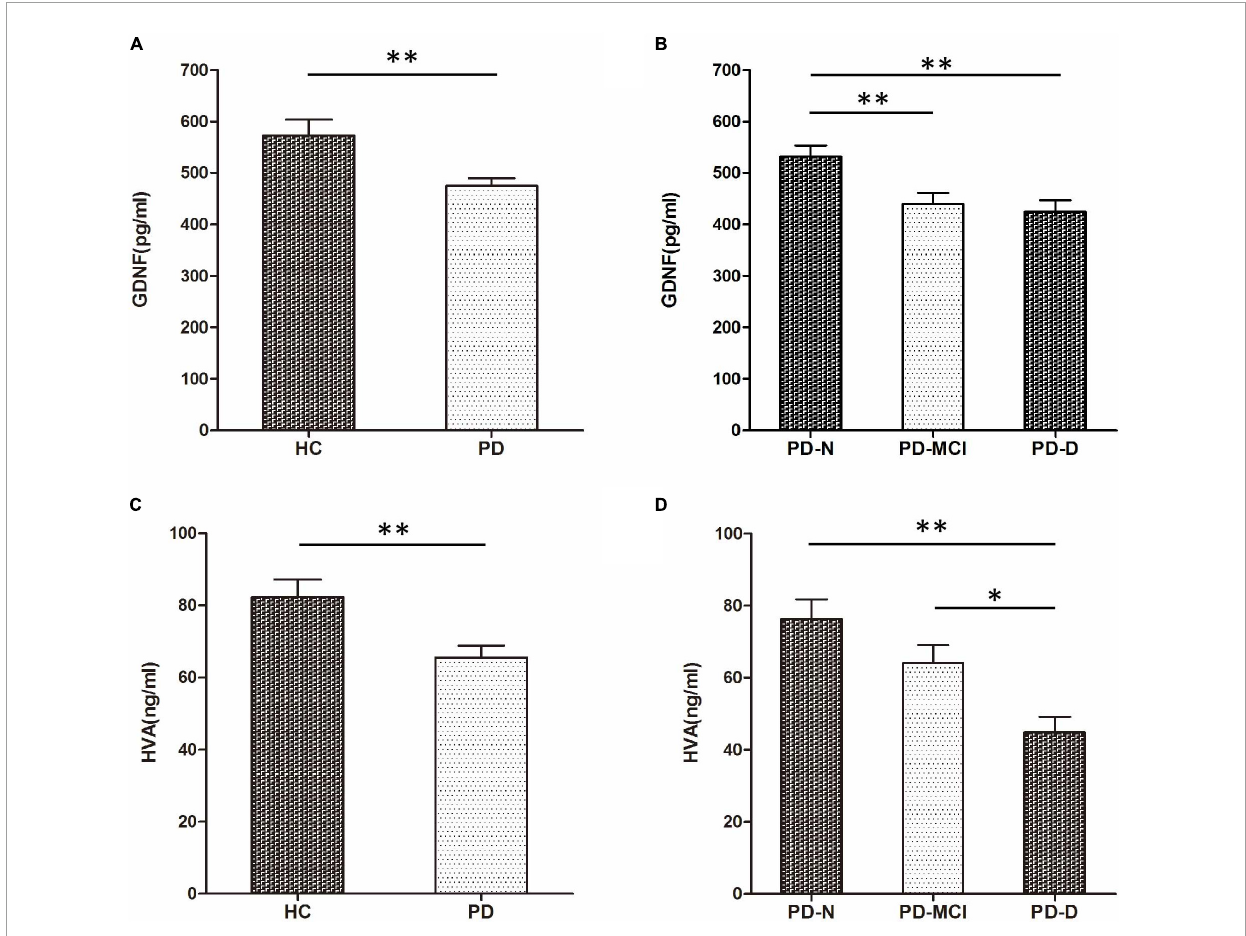
FIGURE1 Comparison of serum glial cell line-derived neurotrophic factor (GDNF) and homovanillic acid (HVA) concentrations among groups. (A) Comparison of serum GDNF concentration between HC and PD groups. (B) Comparison of serum GDNF concentrations among PD-N, PD-MCI, and PD-D groups. (C) Comparison of serum HVA concentration between HC and PD groups. (D) Comparison of serum HVA concentration among PD-N, PD-MCI, and PD-D groups. ∗ P < 0.05 and ∗∗ P < 0.01.